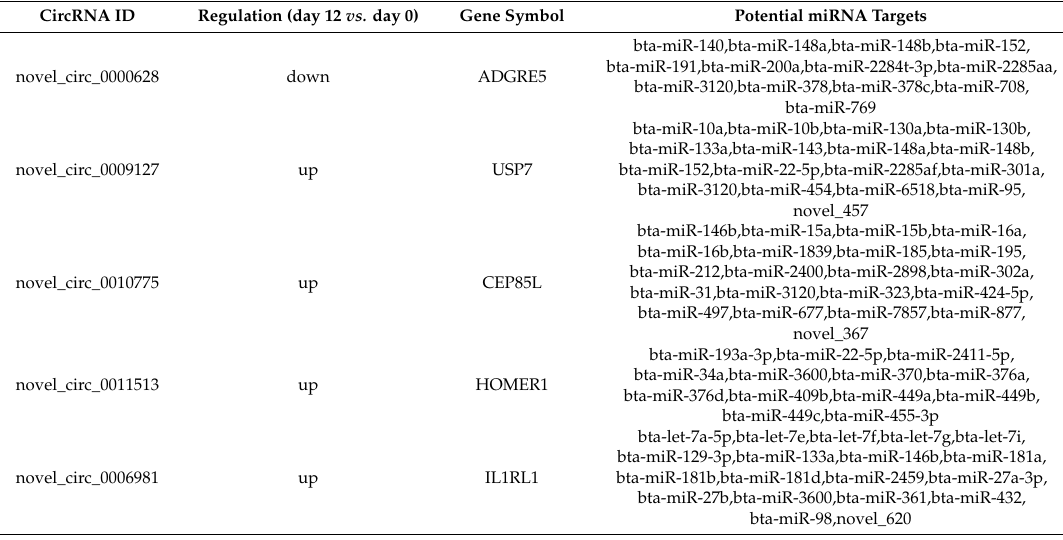
Table 1. Potential miRNA (adipocyte di ff erentiation-related miRNAs) targets of